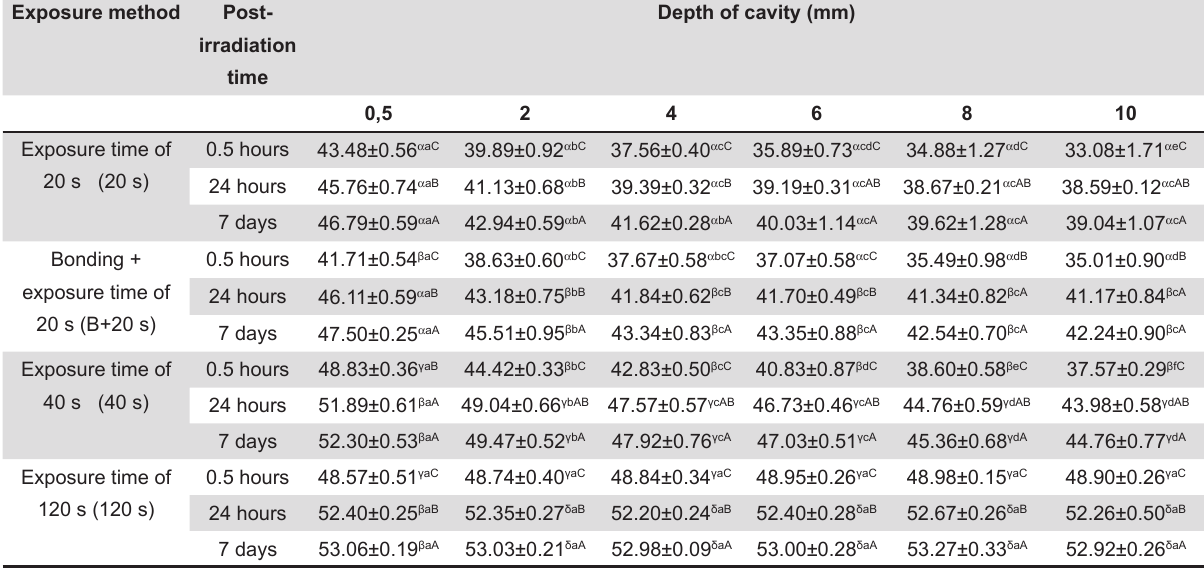
Table 1- Mean KHN±SD for Clearfil DC Core Plus (DCP) at 6 depths of cavity after 3 post-irradiation times by 4 light- exposure methods The same lower-case superscript Greek characters indicate no statistically significant differences between exposure methods at same post-irradiation time in the same depth of cavity; the same lower-case superscript letters indicate no statistically significant differences between depths of cavity at same post-irradiation time in the same exposure method; the same upper-case superscript letters indicate no statistically significant differences between post-irradiation times at same depth of cavity in the same exposure method